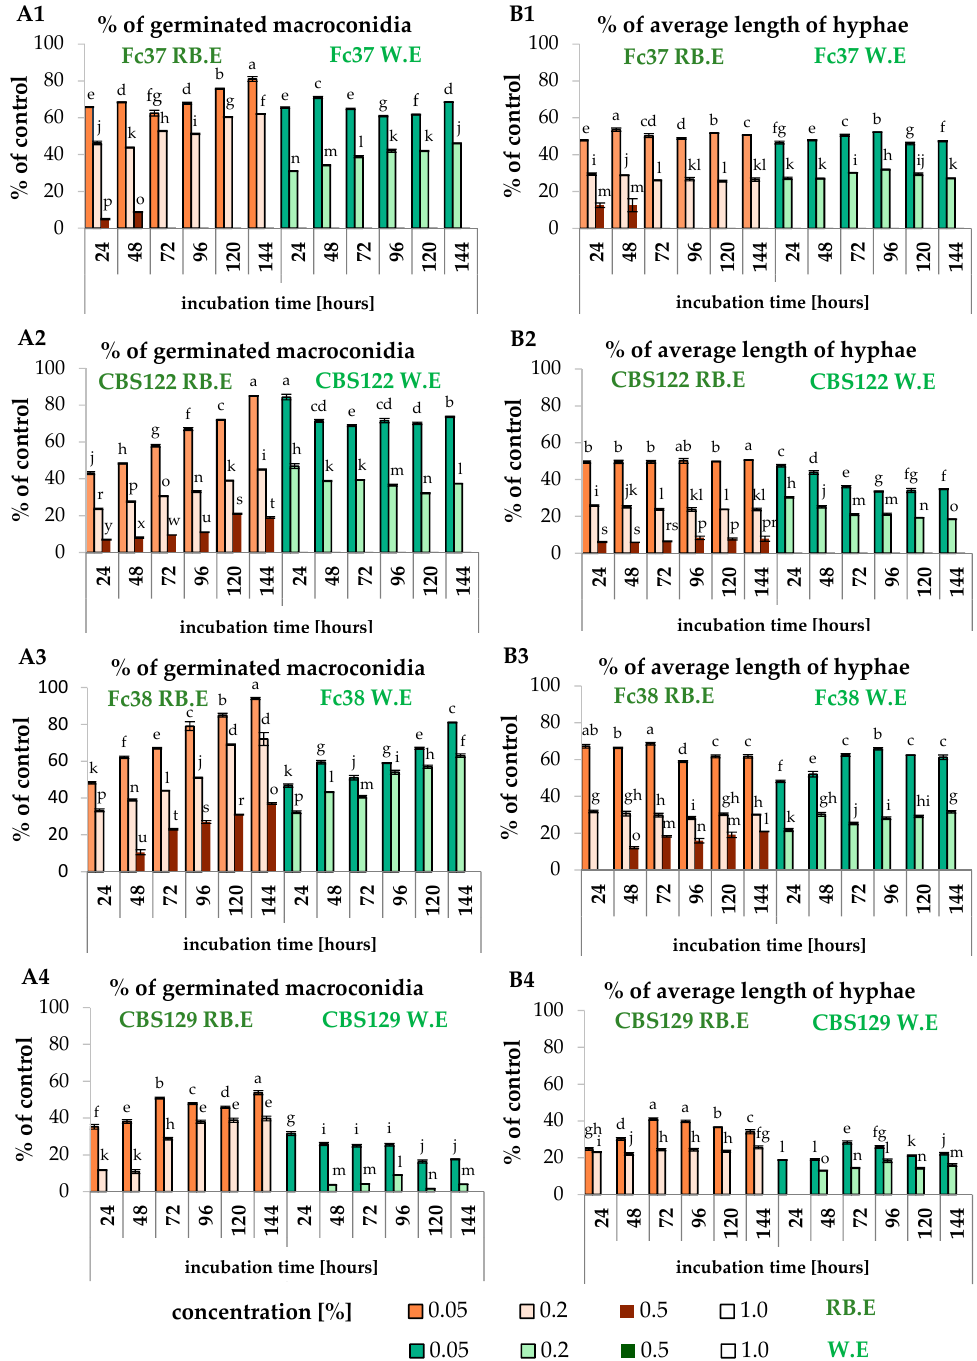
Figure 6. The percentage of germinated macroconidia ( A ) and the percentage of average hyphae length ( B ) of F. culmorum (1 for F. culmorum Fc37; 2 for F. culmorum FcCBS122) and F. oxysporum (3 for F. oxysporum Fo38; 4 for F. oxysporum FoCBS129). Bars represented standard deviations (SD). Values followed by different letters are significantly different (one-way analysis of variance (ANOVA) followed by a Tukey’s post hoc test with the significance evaluated at p < 0.05).